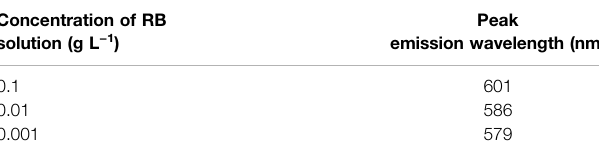
TABLE 3 | Emission spectra of aqueous solutions of rhodamine B at different concentrations. Excitation wavelength 365 nm. Concentration of RB solution (g L − 1